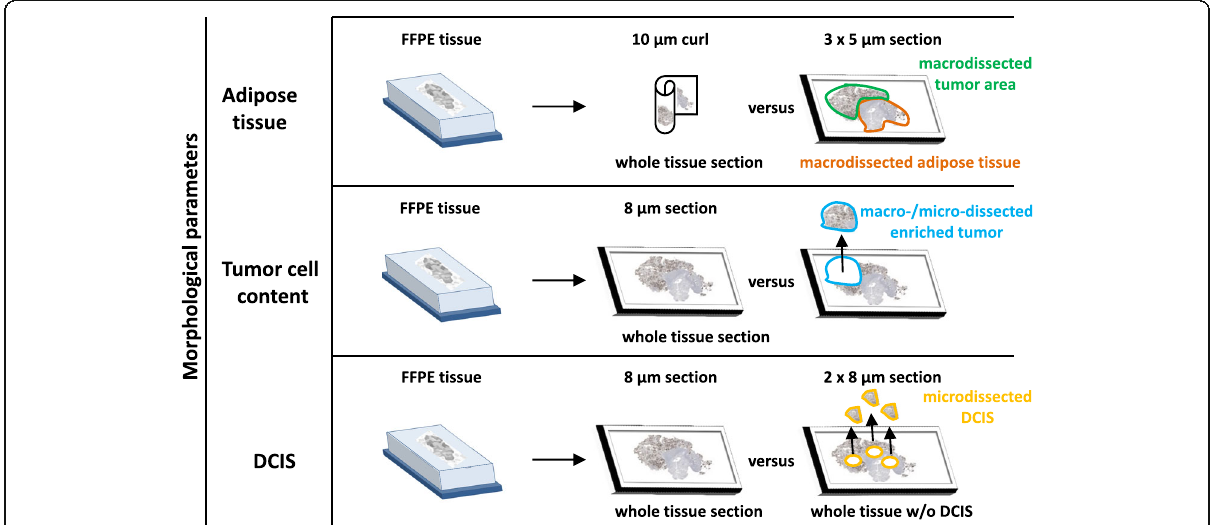
Fig. 1 Schematic overview of sample processing and morphological parameters of investigated